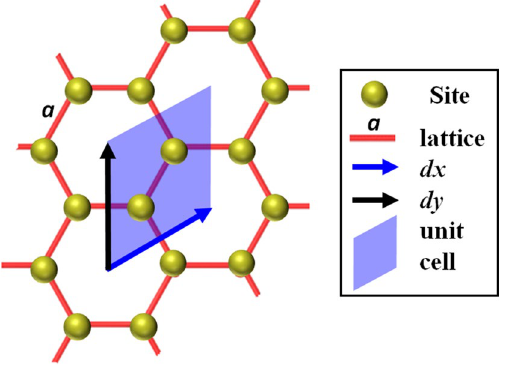
1 ) of localized cations arranged in a honeycomb lattice N / 2 k = = =